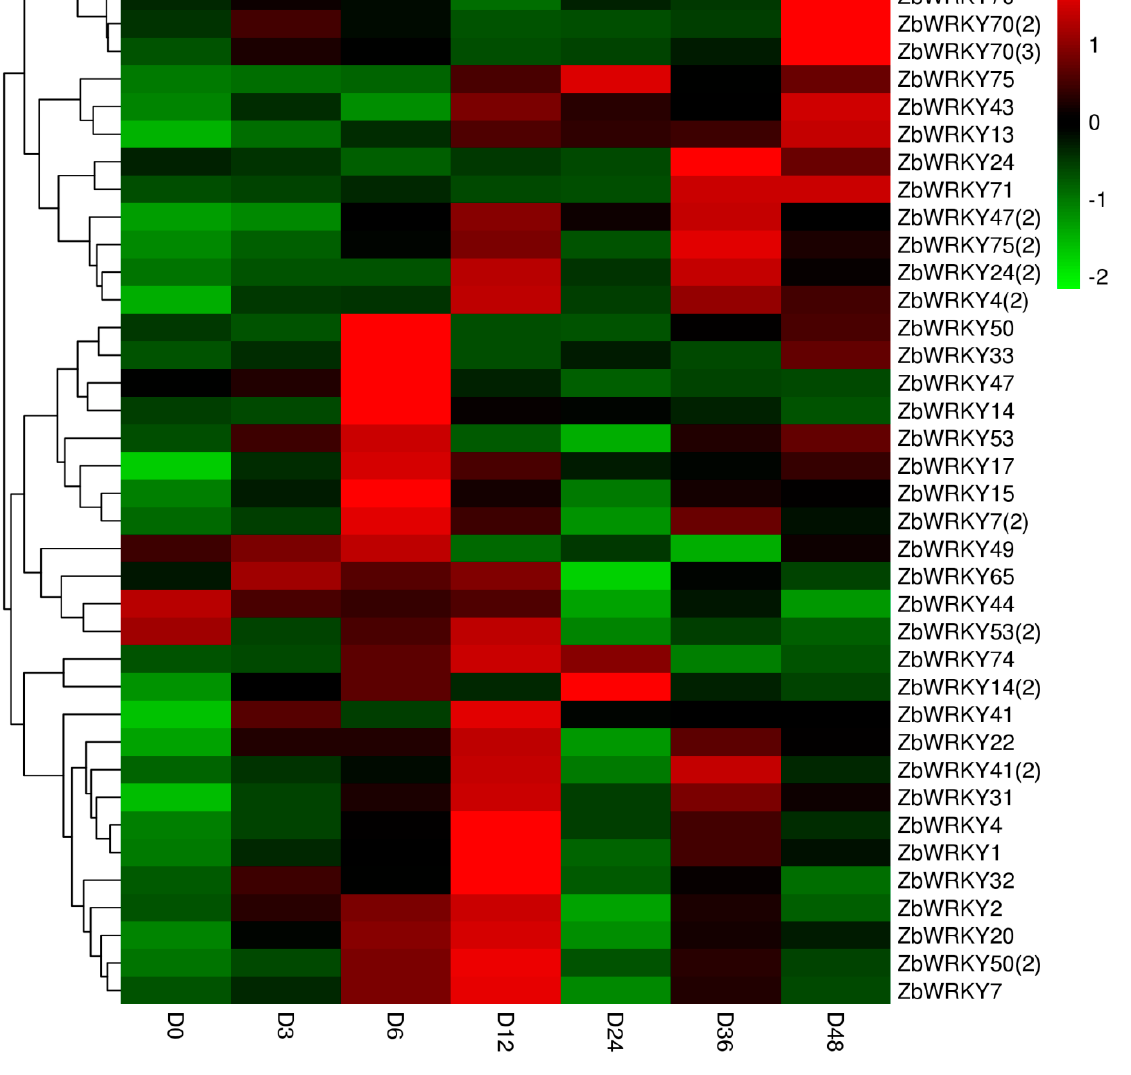
Figure 3. Relative expression heat map of the 38 ZbWRKY genes under drought stress.